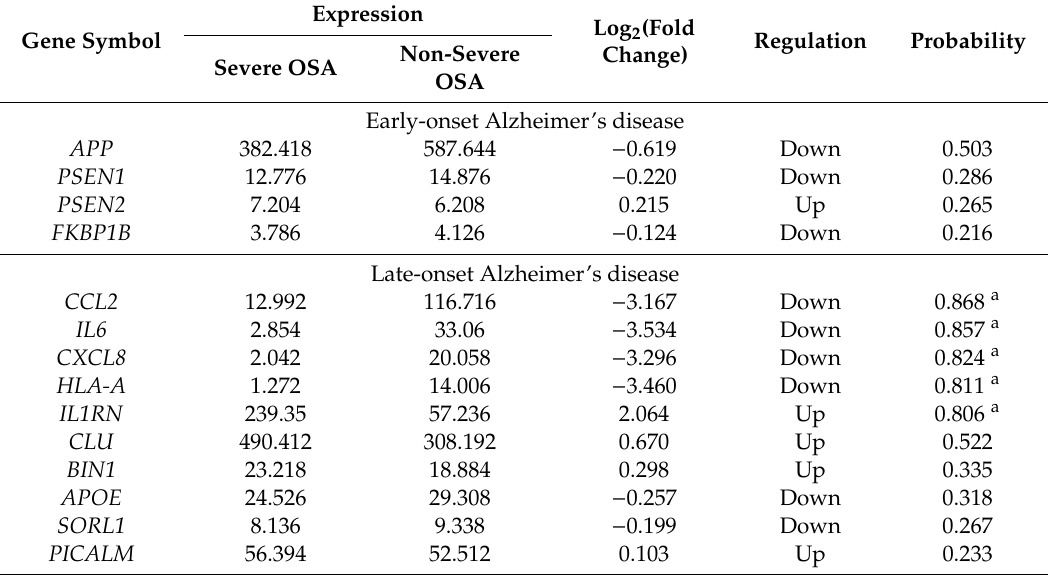
Table 2. Expression of representative Alzheimer’s disease-associated genes among the patients with severe OSA and non-severe OSA in descending order by